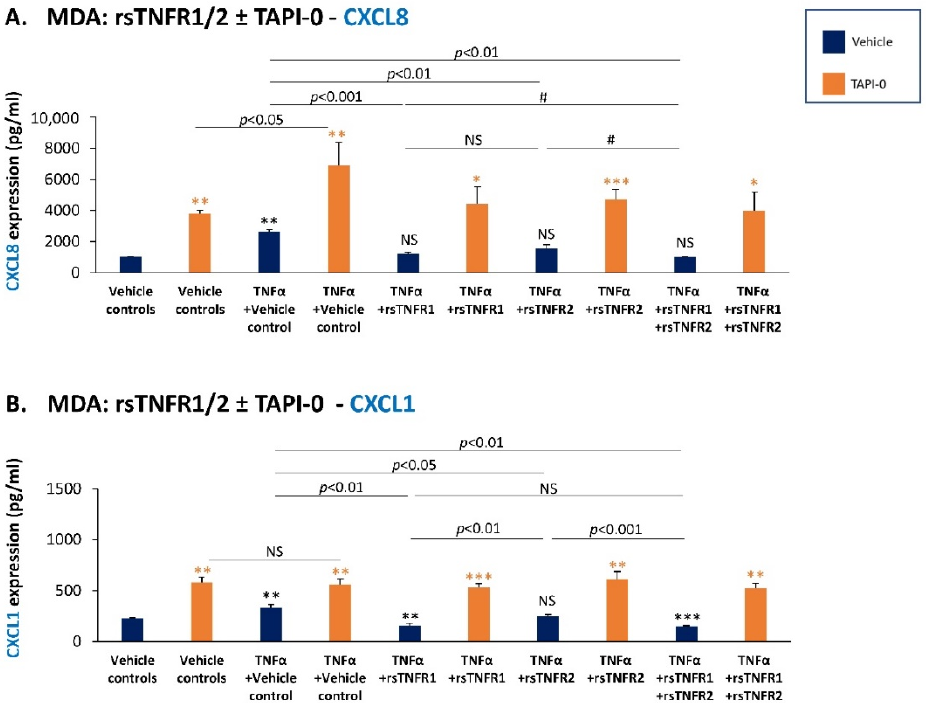
Figure 9. Recombinant and cell-derived sTNFR1 and sTNFR2 have a protective effect against TNF α -induced expression of pro-metastatic chemokines in MDA-MB-231 cells. MDA-MB-231 cells (MDA) were stimulated by TNF α (0.5 ng/mL) that was pre-incubated with rsTNFR1 (150 ng/mL), rsTNFR2 (500 ng/mL), rsTNFR1 + rsTNFR2 (concentrations as before) or their vehicle. When indicated, the cells were cultured prior to TNF α stimulation with TAPI-0 (5 µ g/mL) or its vehicle for 3 h, as well as during cytokine stimulation (TAPI-0 did not affect tumor cell growth). The concentrations of rsTNFR1 and rsTNFR2 were selected as described in Section 2. CM were collected following 24 h stimulation, and CXCL8 ( A ) and CXCL1 ( B ) levels were determined by ELISA. A representative experiment of n = 3 is presented. *** p < 0.001, ** p < 0.01, * p < 0.05. # p < 0.1. NS, not significant. Black asterisks denote the differences in chemokine levels between TNF α -stimulated cells and vehicle-treated cells. Orange asterisks denote the differences in chemokine levels between TAPI-0-treated cells and cells treated by its vehicle. Statistical analyses were performed as described in Section